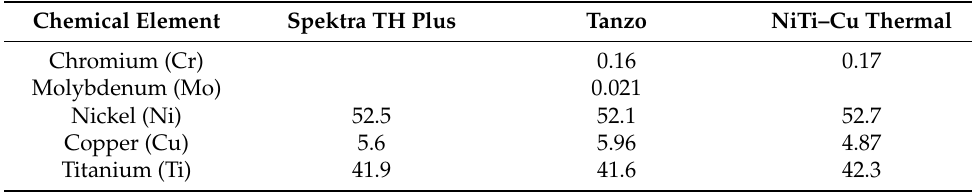
Table 14. XRF results of Thermal archwires. Percentages by weight.